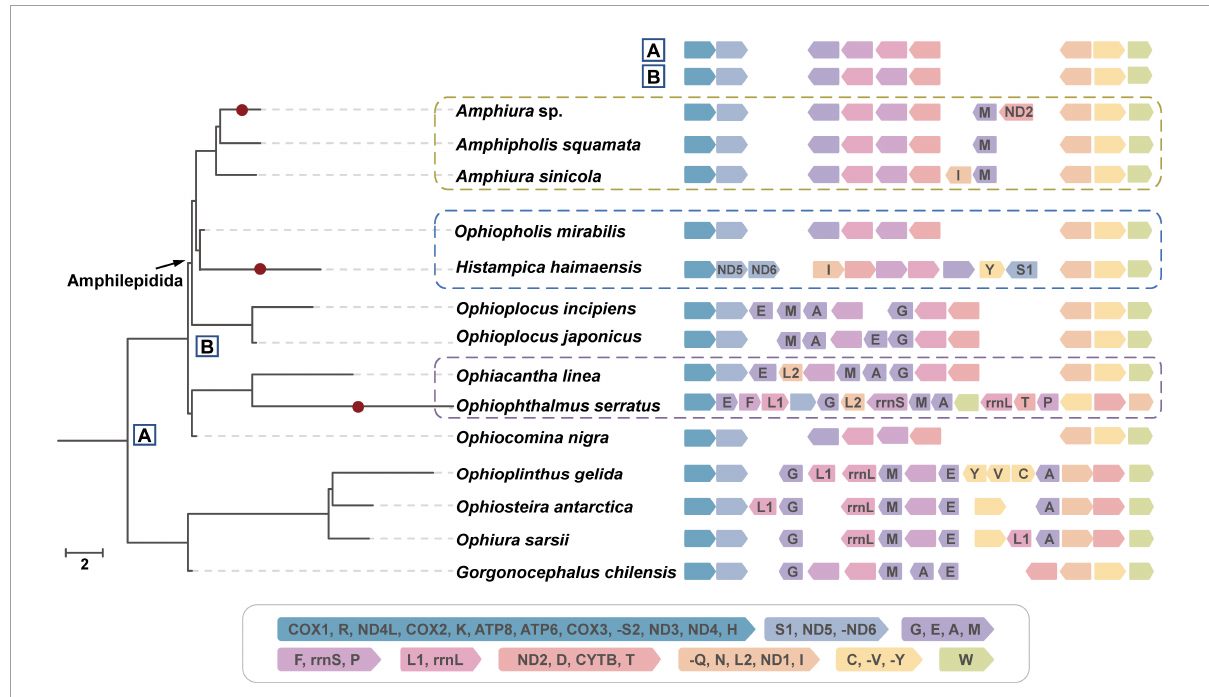
FIGURE4 Rearrangement of MT genes. The same phylogenetic topology as the ML tree was showed on left, with branch length represented reversal distance. Gene order of each species were showed on the right, with two ancestors (box A: Ophiuroidea and box B: Ophintegrida) on top. MT genes were colored according to the blocks in the legend panel, where tRNA genes are labeled by one uppercase letter amino acid abbreviations. Blocks with arrow point to right means the same order as those in the legend, otherwise, it is